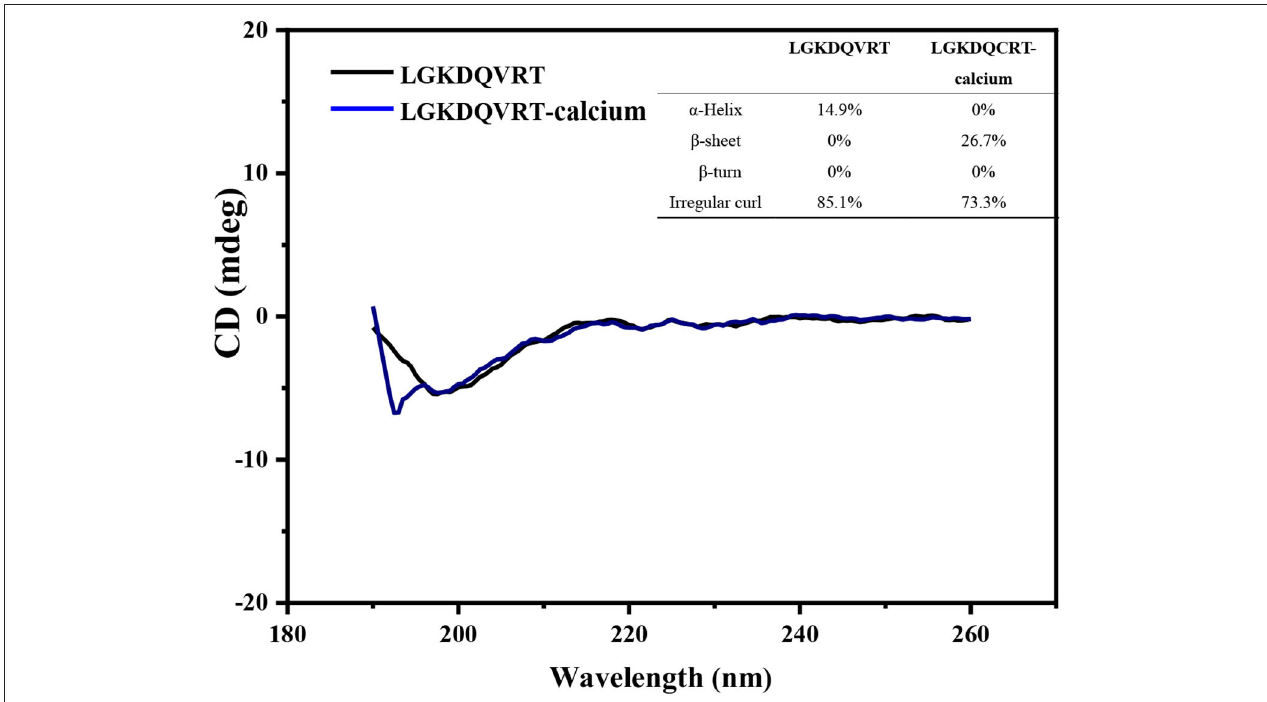
FIGURE 2 | Far-UV circular dichroism spectroscopy of the LGKDQVRT and LGKDQVRT-calcium complex over the range of 190–260nm, insets show their secondary structure relative content of α -helix, β -sheet, β -turn and random coil.